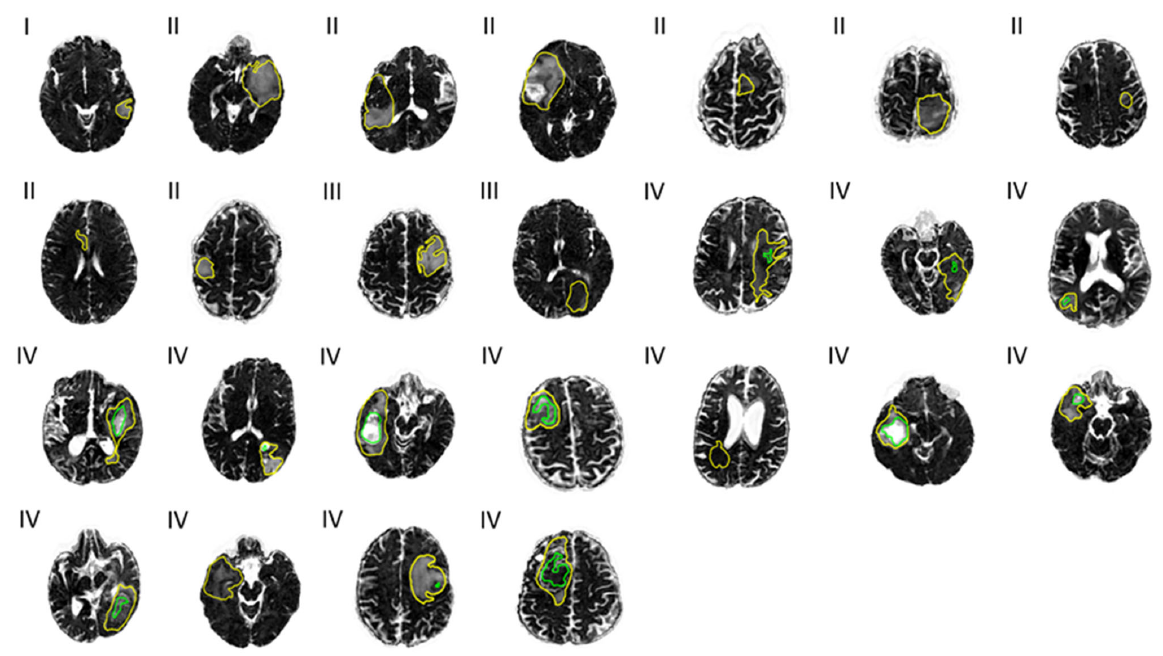
Figure 3. Free water ( FW ) maps across 25 patients. Tumor grades I, II, III, and IV are noted to the top left at each map. Outlines of the total tumor regions (yellow) and necrotic tumor regions (green) are overlaid.